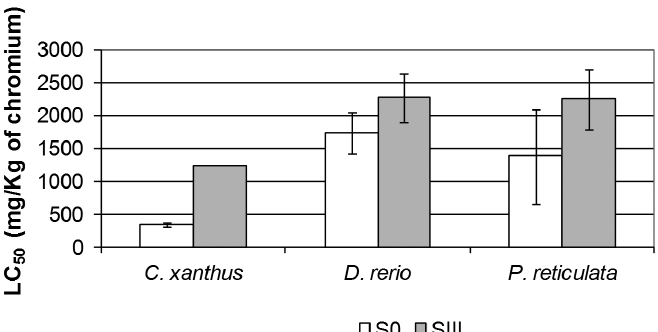
Figure 1. Mean LC50 values and standard deviations (^) in the acute toxicity tests with artificial sediments (S0 and SIII) utilizing C. xanthus, D. rerio and P. reticulata as test organisms.